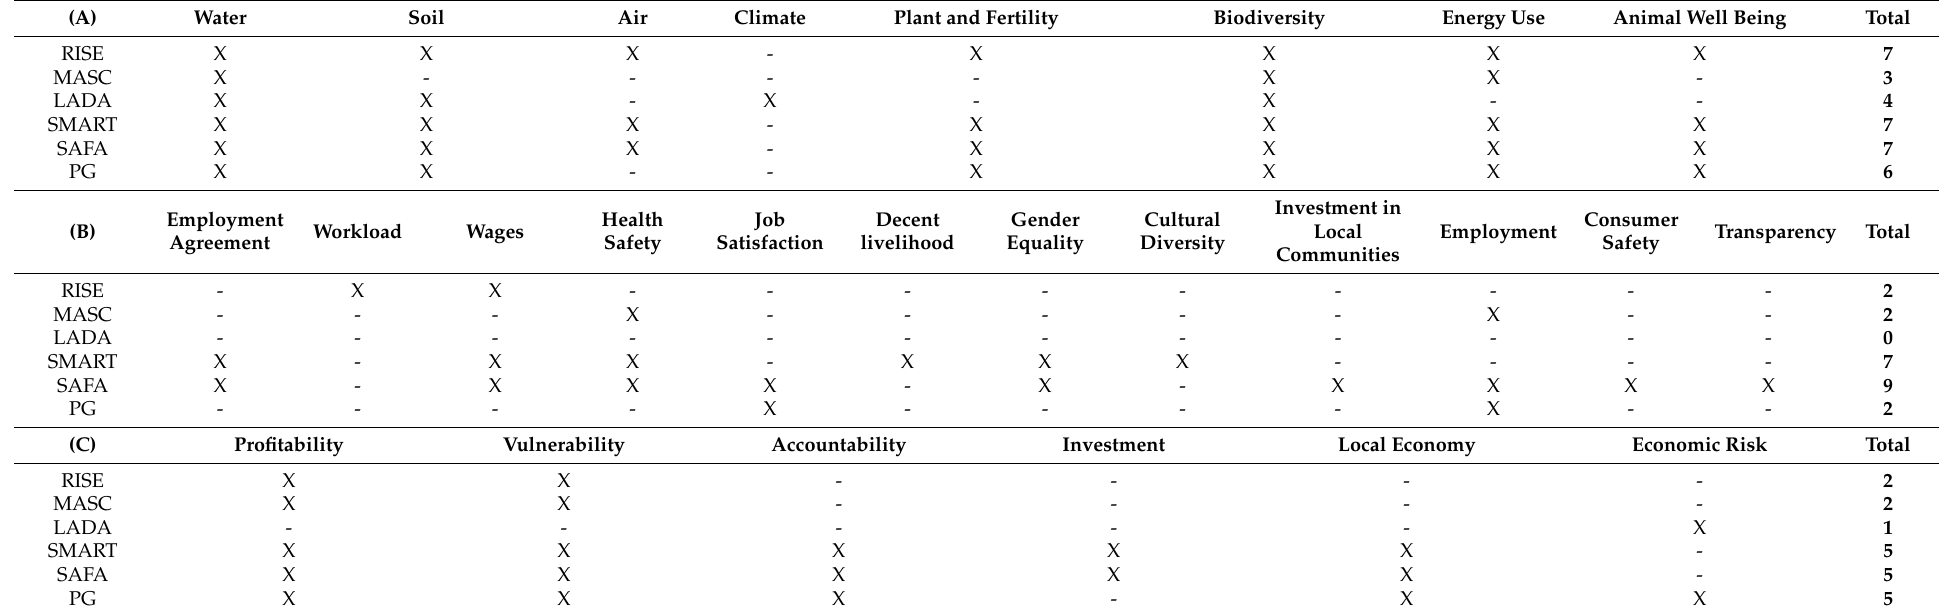
Table 5. Framework’s scoring based on their environmental ( A ), sociocultural ( B ) and economic ( C ) assessment